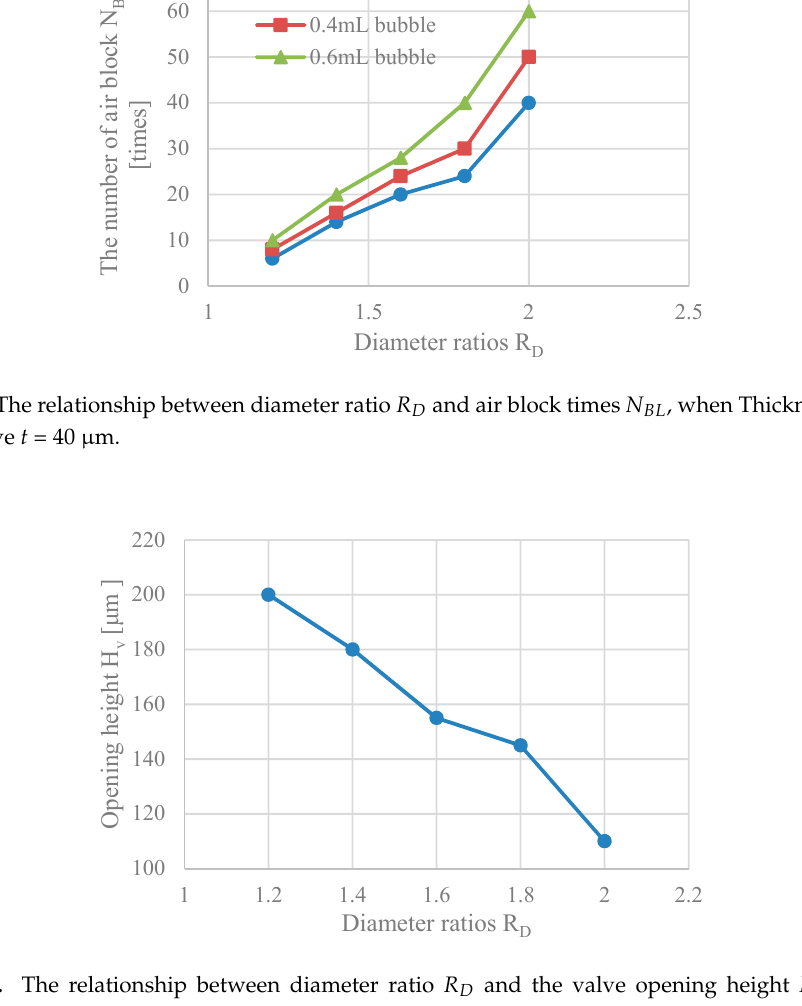
Figure 11. The relationship between thickness t and air block times N BL , when R D = 1.2.